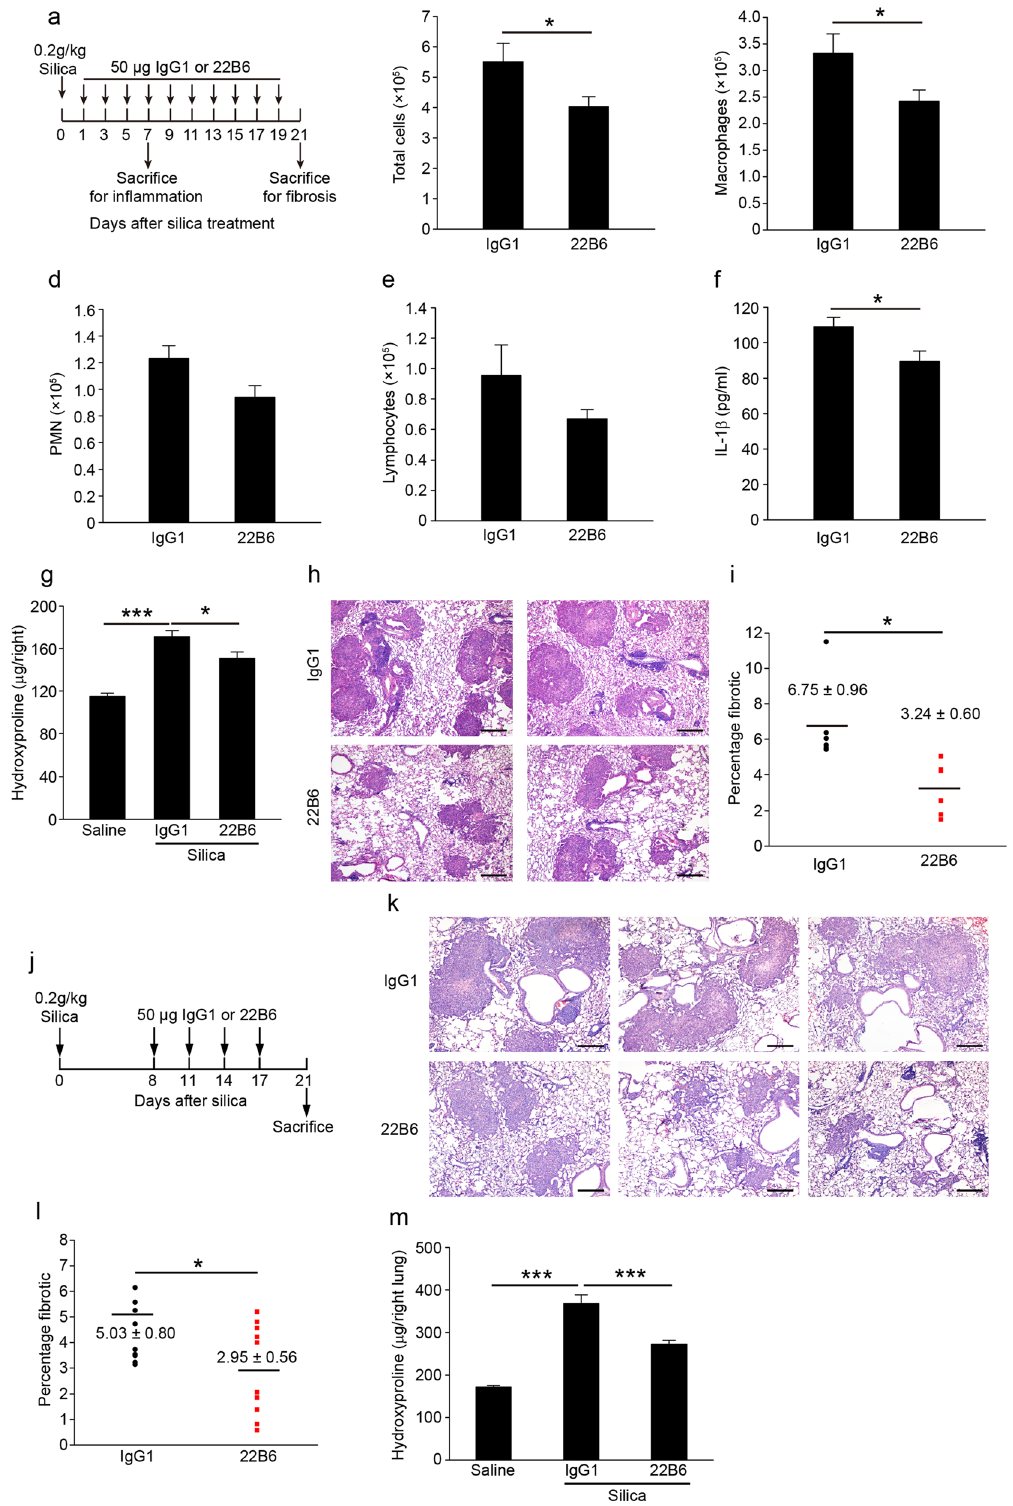
Figure 6. FSTL1-neutralizing antibody attenuates silica-induced lung inflammation and subsequent pulmonary fibrosis in mice. ( a ) In a FSTL1 blockage experiment, C57BL/6 mice were intraperitoneally injected with 22B6 mAb or IgG1 (n = 6 per group) every other day from 1 day after silica challenge till the mice were sacrificed on day 7 for inflammation analysis or day 21 for fibrosis analysis. ( b–f ) For inflammation analysis, ( b ) the number of total BALF cells was determined by hemocytometer ( * P < 0.05 by one-way ANOVA followed by Student’s t test). ( c–e ) The differential cell counts in BALF were determined according to